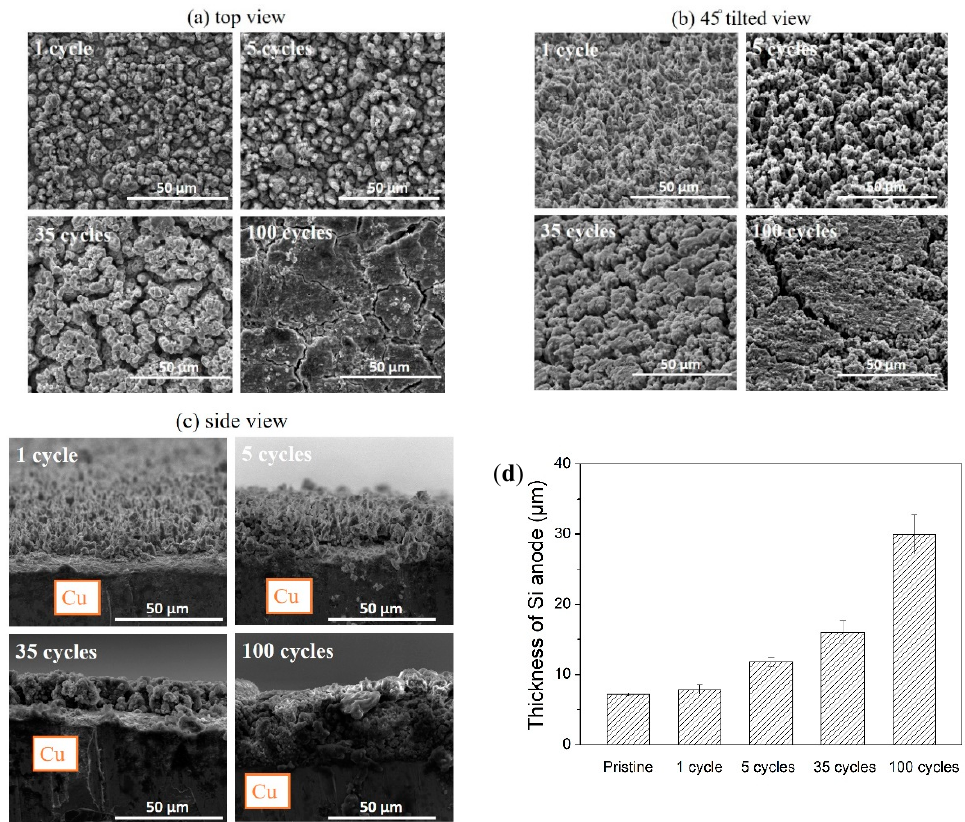
Figure 5. SEM images of Si micropillars after a varying number of cycles from ( a ) top view; ( b ) 45 ◦